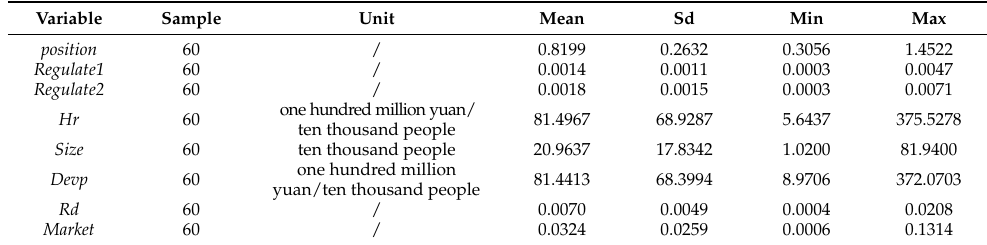
Table 2. Descriptive statistical analysis of main